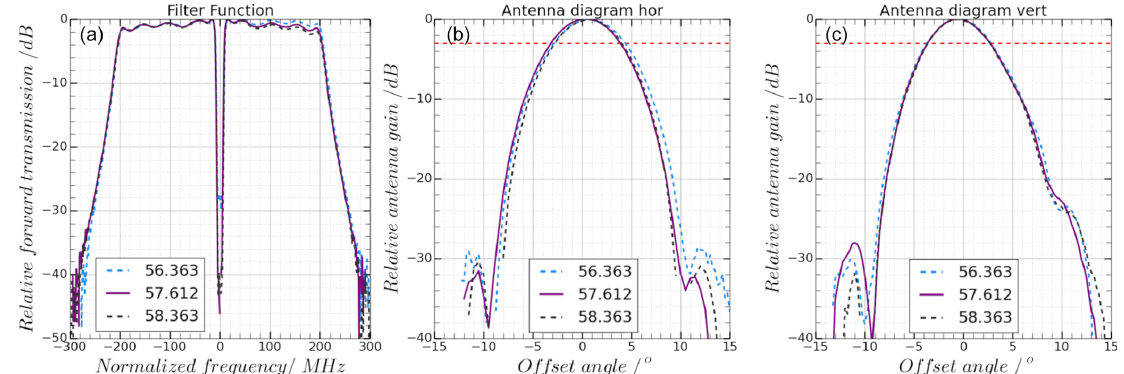
Figure 2. HALO MTP filter functions (a) and antenna diagram of the horizontal (b) and vertical (c) plane recorded at standard measurement frequencies. Red dashed lines indicate the half-maximum value. All data are normalized so that the maximum value shown is 0.